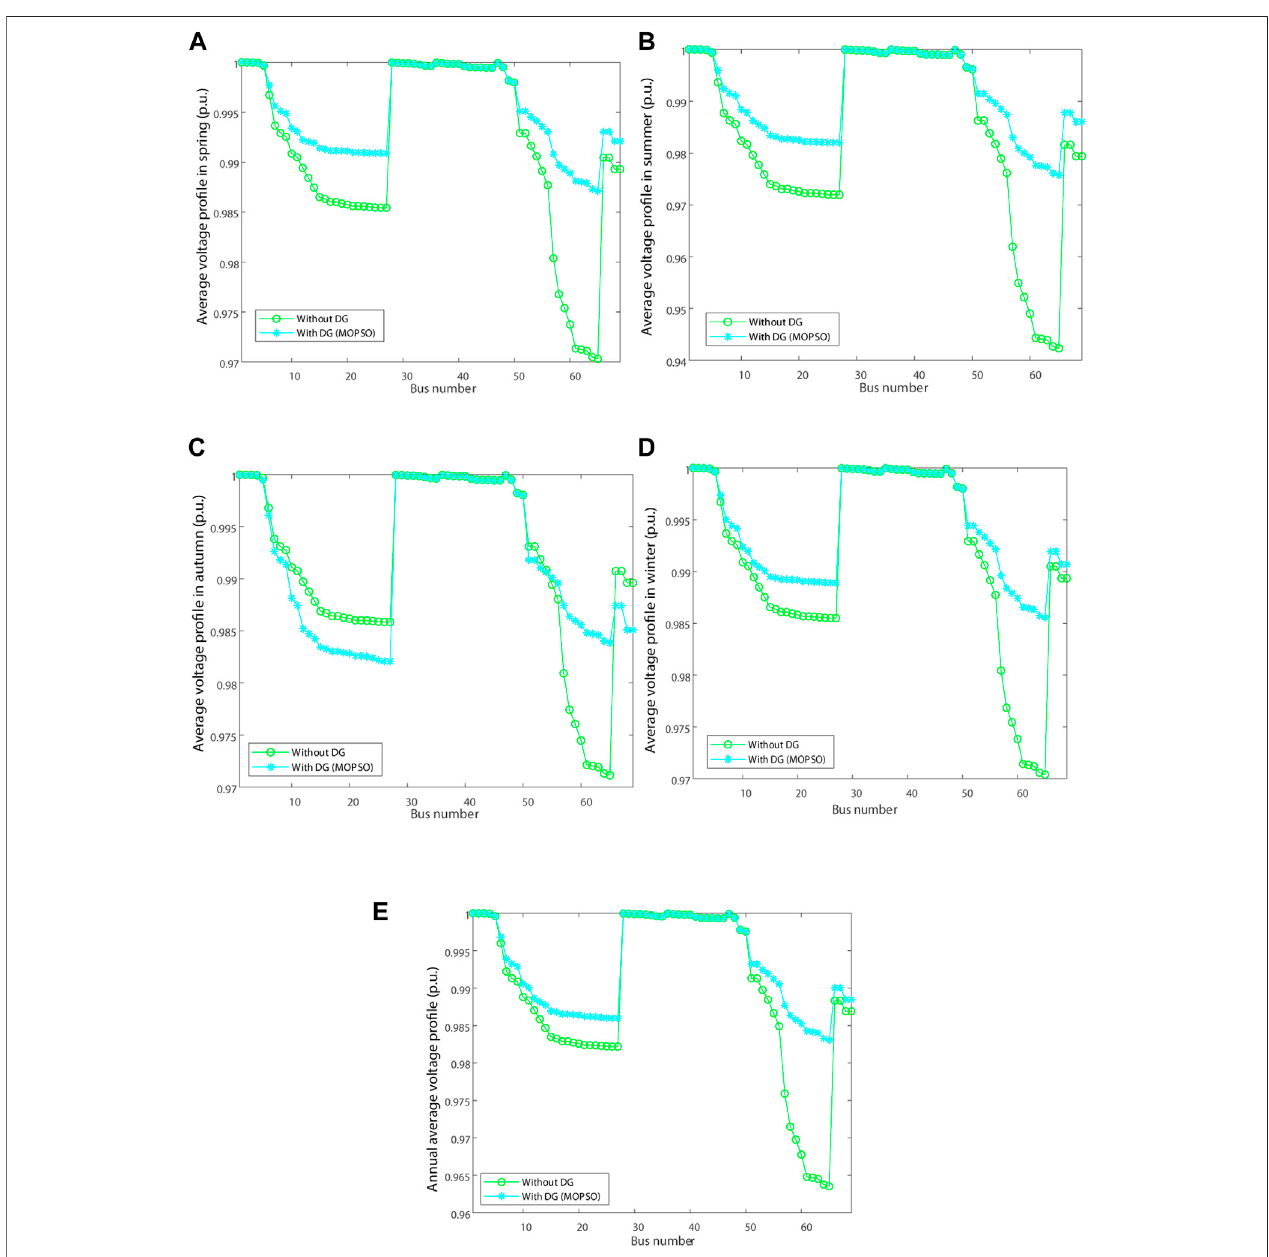
FIGURE 9 | Voltage pro fi le improvement of the IEEE 69-bus distribution